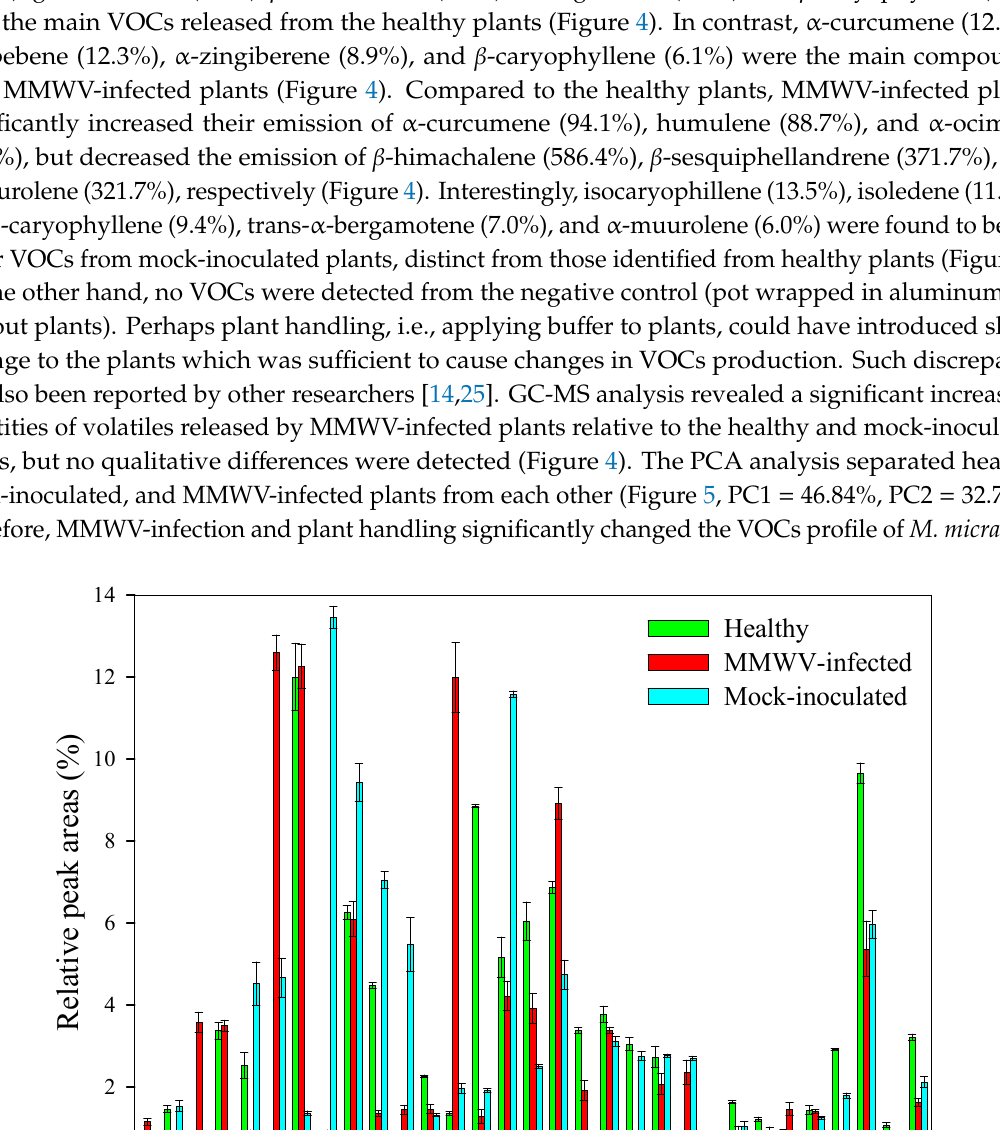
Figure 3. Distribution of alate Myzus persicae in response to contact cues of healthy, mock-inoculated and MMWV-infected plants after 30 min and 60 min. ( A ) Healthy vs. MMWV-infected plants, ( B ) Mock-inoculated vs. MMWV-infected plants, ( C ) Healthy vs. mock-inoculated plants. Each replicate (n = 15) consisted of fifty alate M. persicae . Asterisks indicate significant differences (* p < 0.05, ** p < 0.01, *** p < 0.001) .